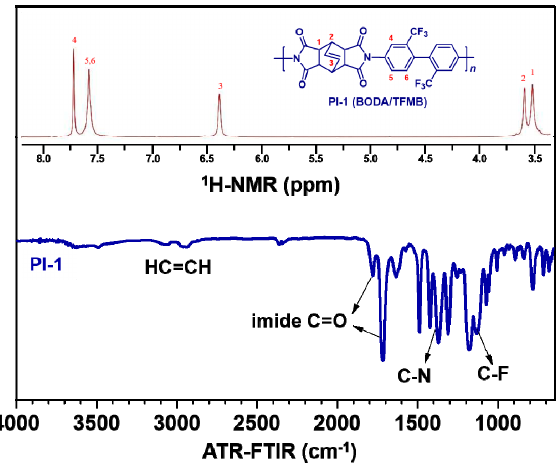
Figure 1. Attenuated total reflectance Fourier transform infrared spectroscopy (ATR-FTIR) and 1 H-nuclear magnetic resonance ( 1 H NMR) spectra of representative PI-1 film.